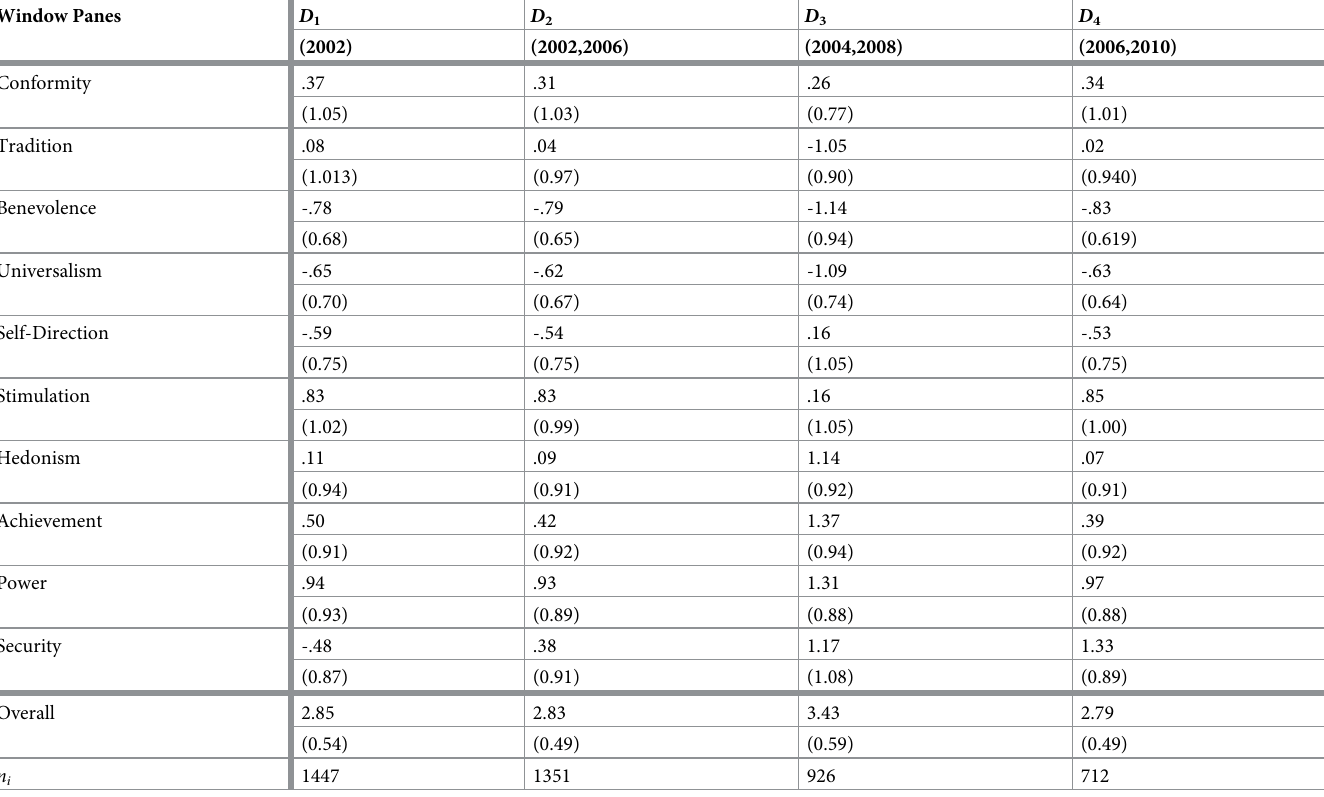
Table 4. Values scores and MART for cluster C 11 at respective time points. Window